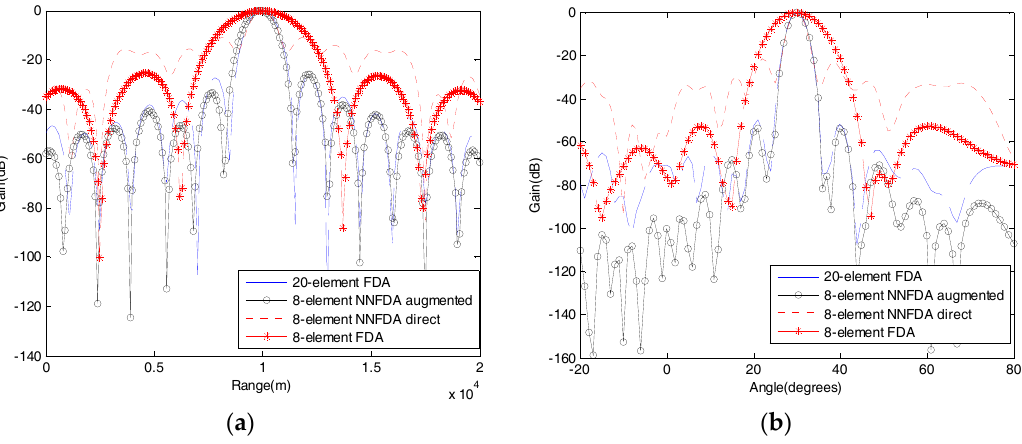
Figure 6. Ranges and angle scanning of the normalized beampatterns: ( a ) range scanning at the desired direction ( θ 0 = 30 ◦ ); ( b ) angle scanning at the desired range ( r 0 = 10km).